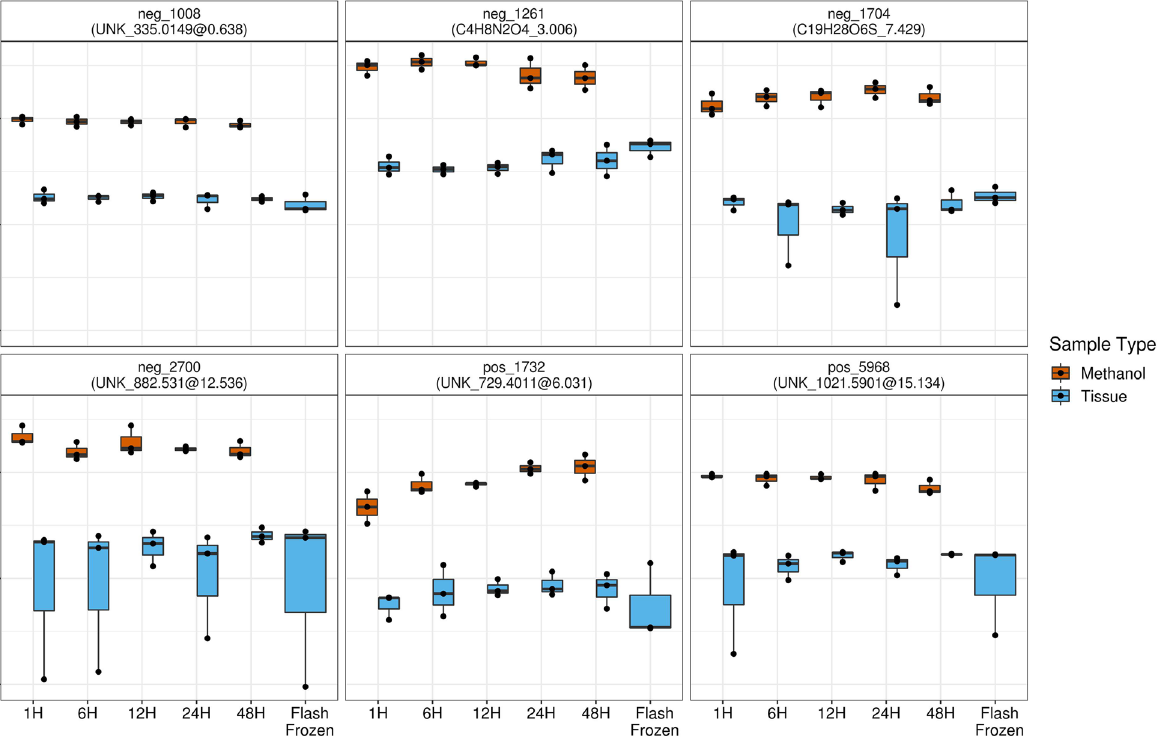
Figure 3. Six randomly selected metabolite features by sample type (tissue vs methanol extract) and methanol fixation time. H hours, neg negative, pos